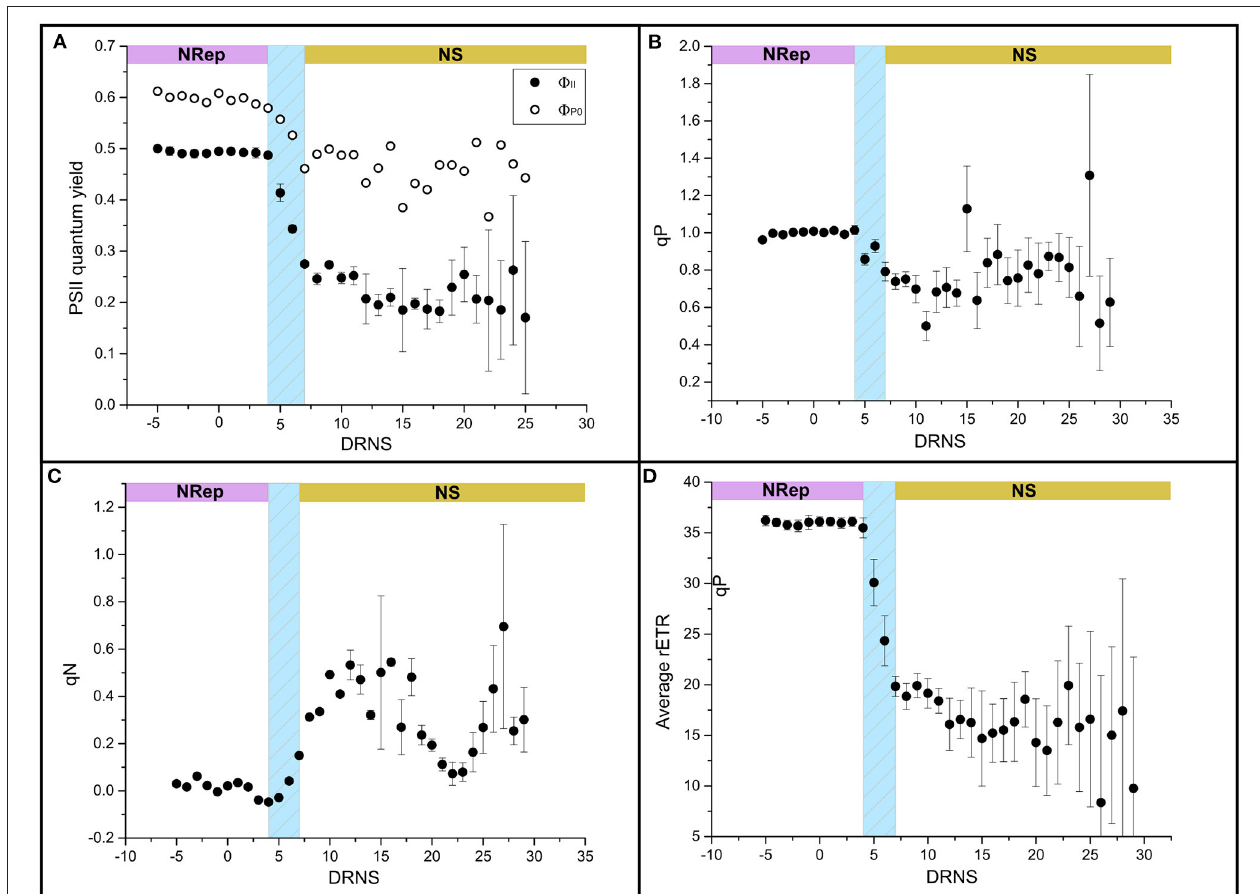
FIGURE 2 | Impact of NS on the photosynthetic performance. (A) Light-adapted state ( 8 II) (closed symbol) and dark-adapted state ( 8 P0) (open symbol), (B) photochemical quenching (qN), (C) photochemical quenching (qP), and (D) relative electron transport rate (rETR).